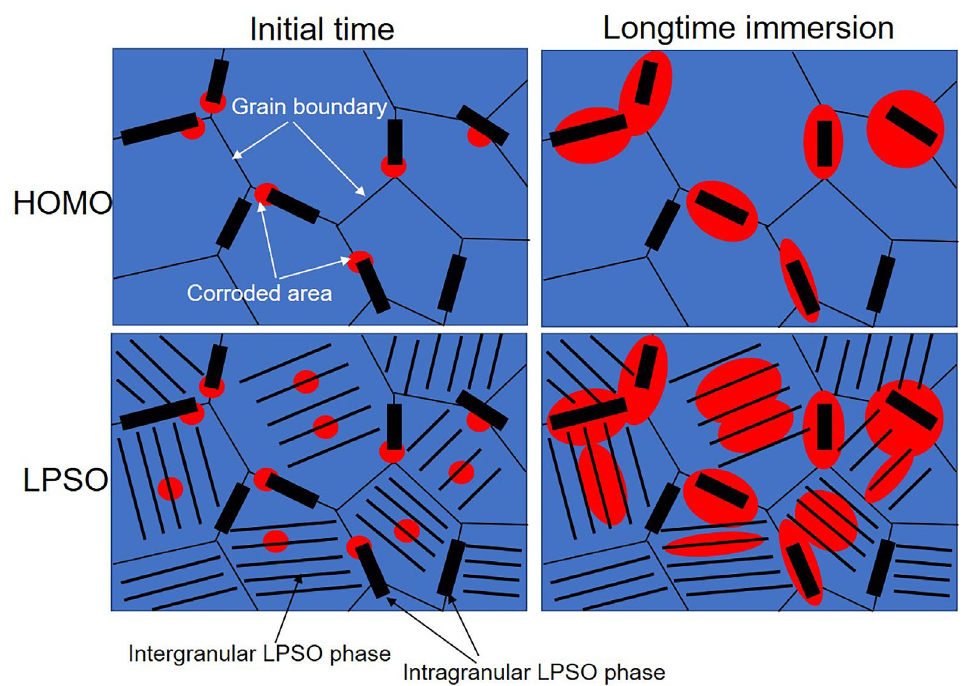
Figure 13. Schematic illustration shows intragranular LPSO phases’ influence on the surface